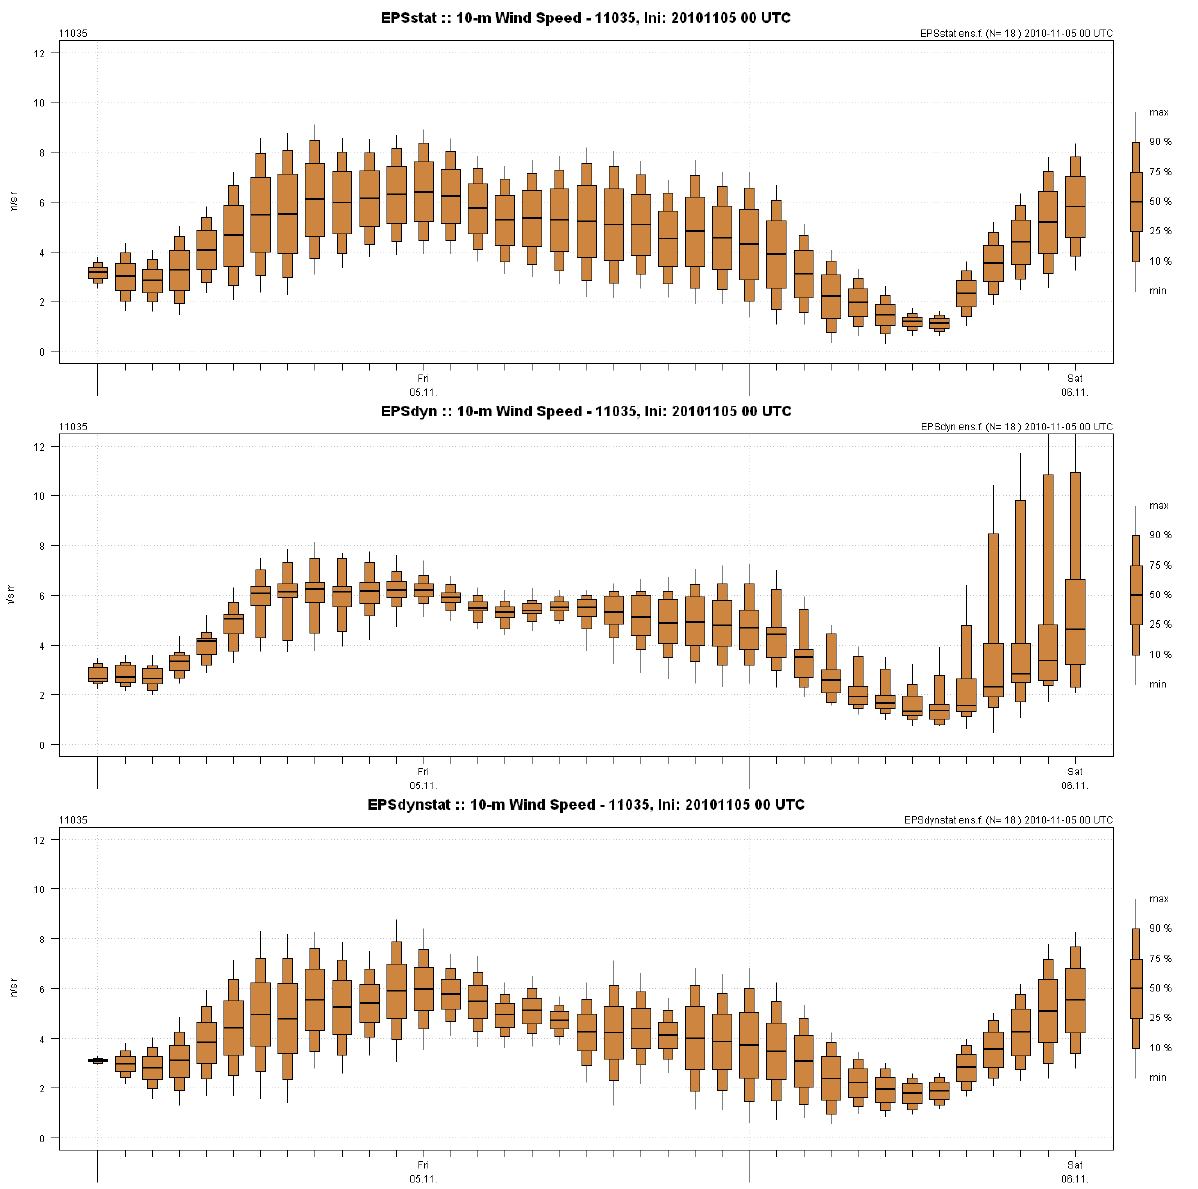
Figure 2. EPSgrams for 10-m wind speed, calculated with the three different methods, forecast initialized at 5 November 2010, 00:00 UTC, for station Vienna Hohe-Warte.